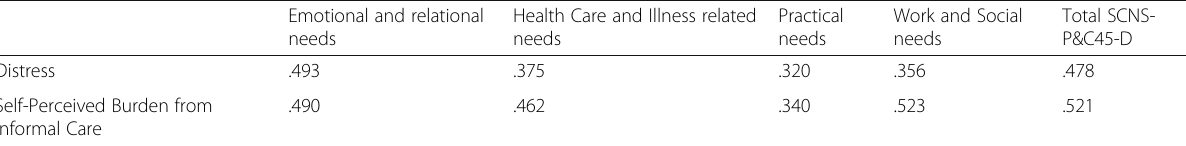
Table 3 Correlations between the SCNS-P&C45-D domains and distress and Self-Perceived Burden from Informal Care ( n = 272) Emotional and relational